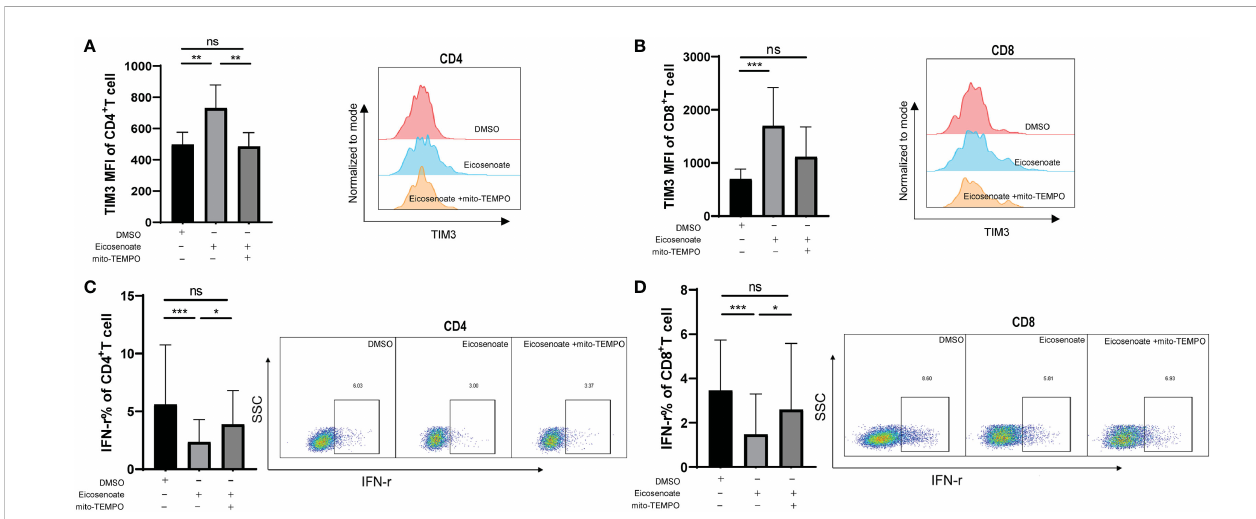
FIGURE 5 The mitochondrial antioxidant mito-TEMPO restores eicosenoate-induced T-cell dysfunction. (A) Primary CD3 + T cells were stimulated with 500 m M eicosenoate and anti-CD3/CD28-coated Dynabeads (4:1 ratio) for 24 h, with or without 200 m M mito-TEMPO, and the expression of the exhaustion indicator TIM3 on the T-cell surface was detected. Eicosenoate-induced increases in TIM3 MFI on CD4 + T cells was completely restored by treatment with 200 m M mito-TEMPO (n = 6). (B) After treatment with 200 m M mito-TEMPO, TIM3 MFI on CD8 + T cells induced by eicosenoate tended to decrease (n = 6). (C) Primary CD3 + T cells were stimulated with 500 m M eicosenoate and anti-CD3/CD28-coated Dynabeads (4:1 ratio) for 24 h, and IFN- g expression was detected. The eicosenoate-induced reduction in IFN- g in CD4 + T cells was restored by 200 m M mito-TEMPO (n = 9). (D) The eicosenoate-induced reduction in IFN- g in CD8 + T cells was prevented by treatment with 200 m M mito-TEMPO (n = 9). Representative fl ow cytograms are shown in each panel. * P < 0.05, ** P < 0.01, and *** P < 0.001. P values were calculated by Friedman test (A – D) . ns, no signi fi